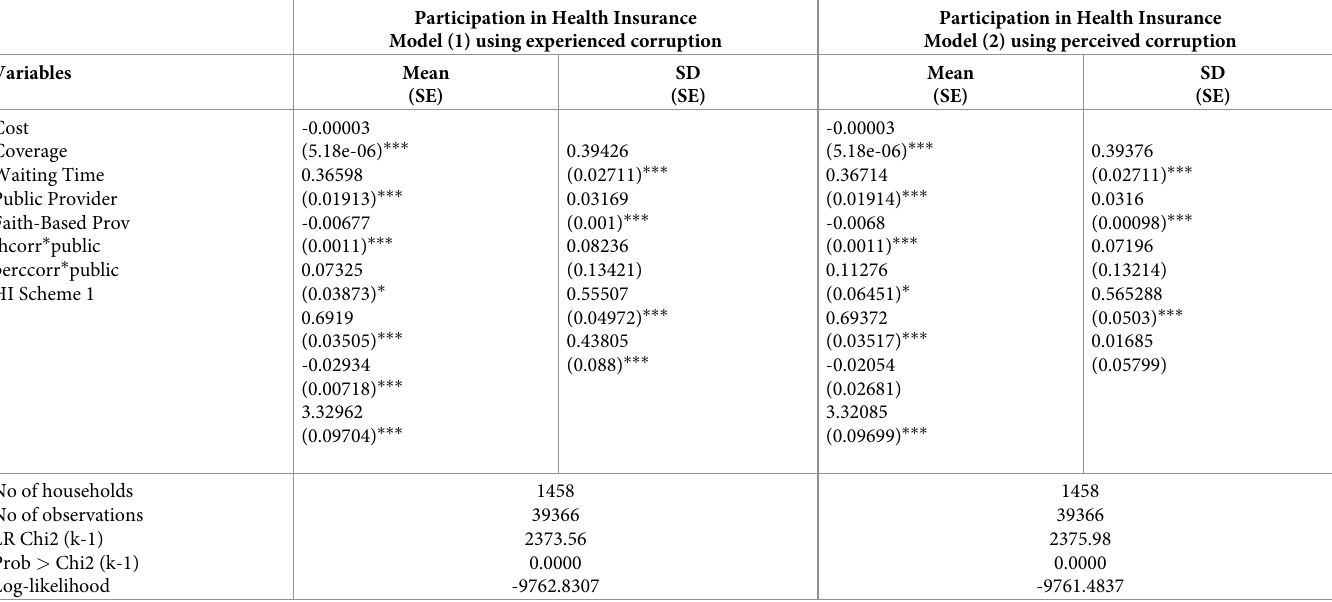
Table 6. The Impact of corruption on households’ participation in health insurance-mixed